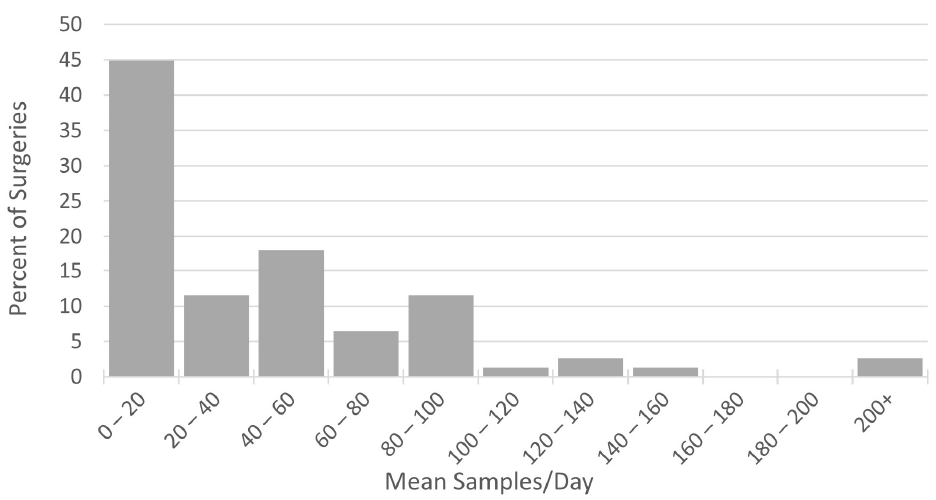
Figure 3. Distribution of mean samples per day generated by GP surgeries. Number of GP surgeries is 78.